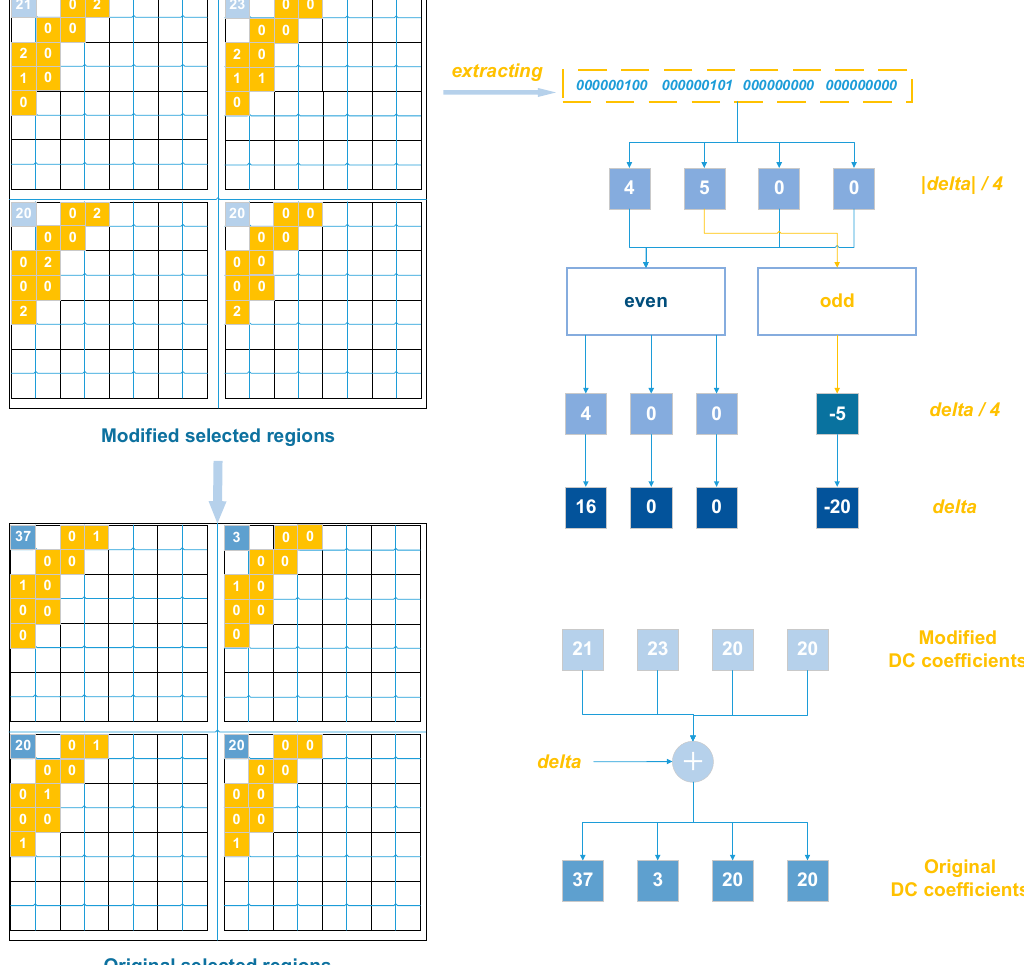
Figure 4. Examples of recovering DC coefficients in selected blocks.